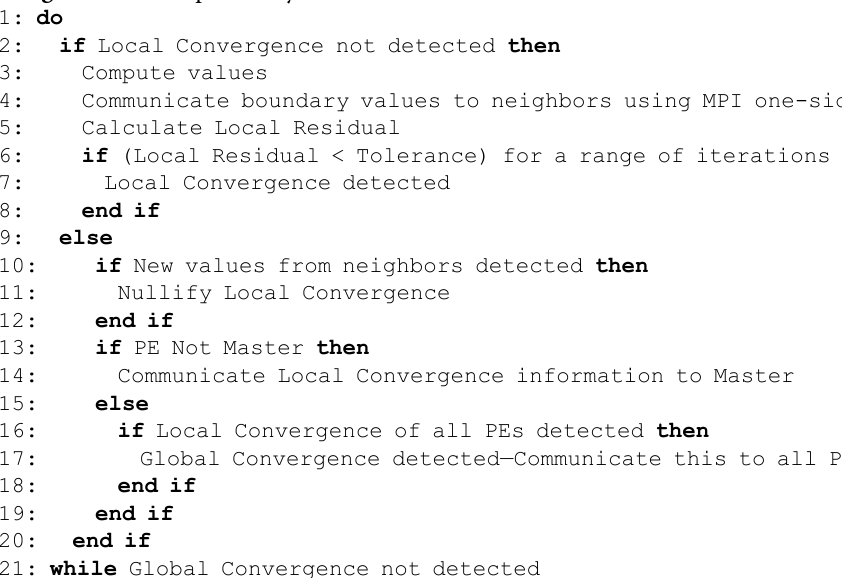
Algorithm B : Proposed Asynchronous Solver